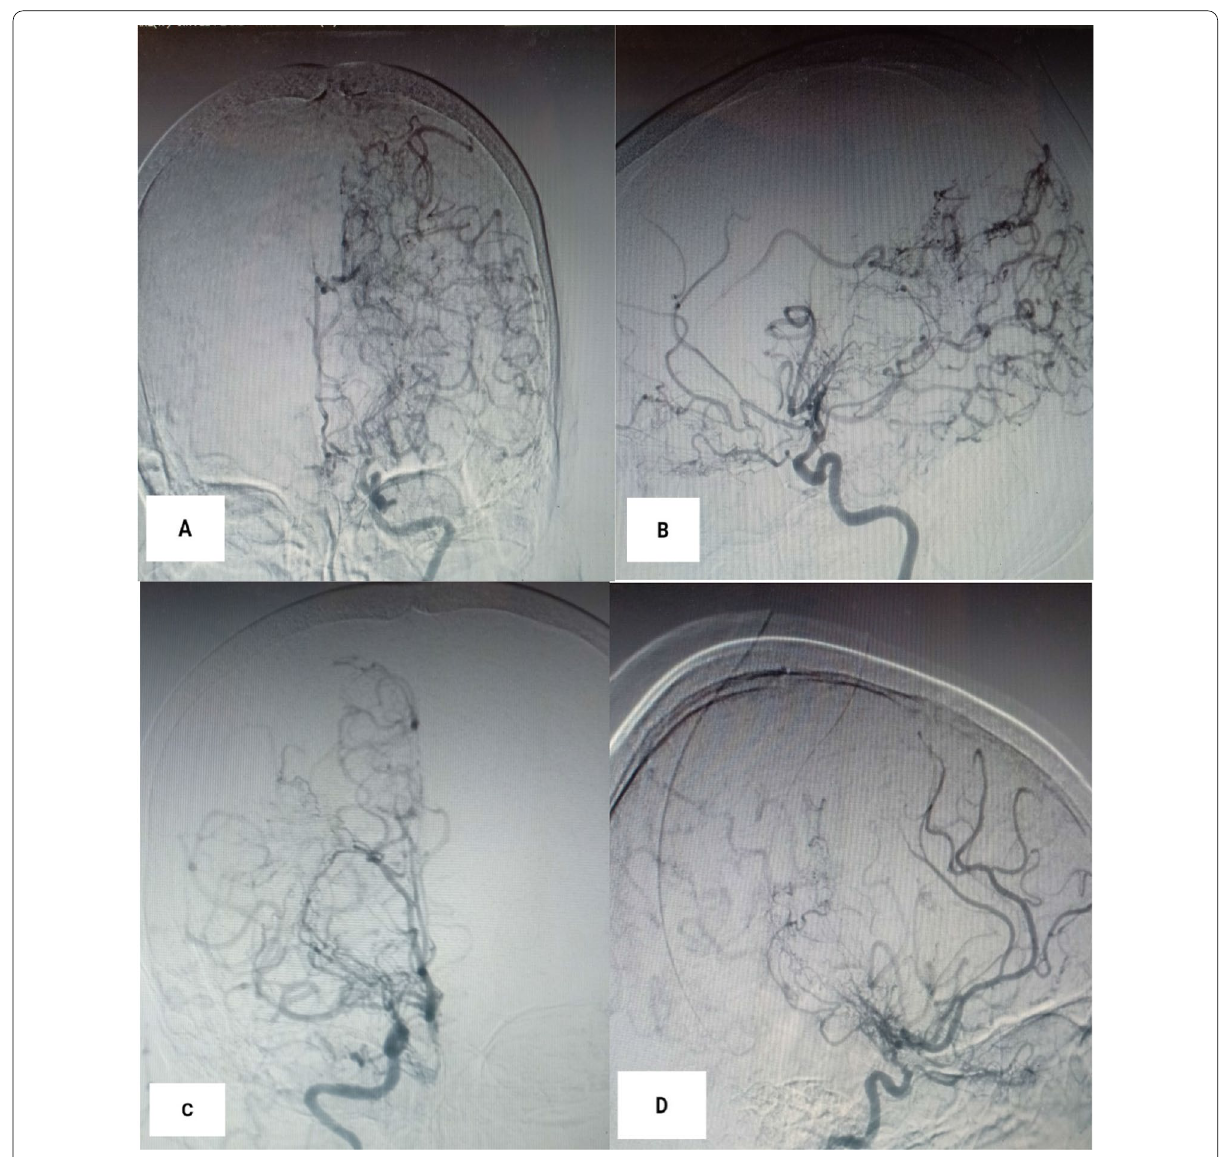
Fig. 2 A Left internal carotid artery (ICA) angiogram anterior view showing occlusion of its distal part of with neo‑angiogenesis. B Left ICA angiogram lateral view. C Right ICA angiogram anterior view showing occlusion of its distal part with neo‑angiogenesis. D Right ICA angiogram lateral